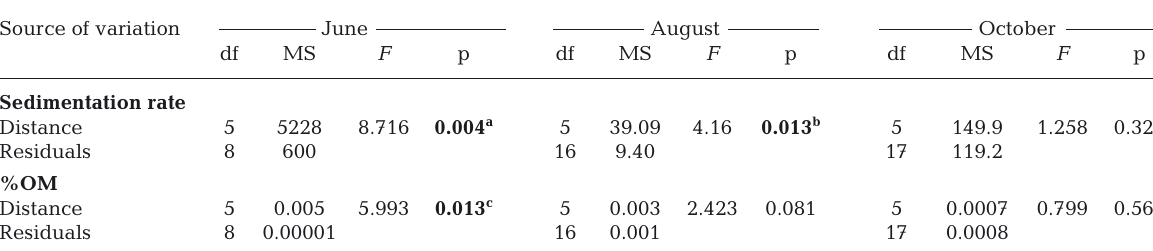
Table 1. Results of ANOVA evaluating the effect of distance on sedimentation rate and organic matter content (%OM) in sediment traps under the double density longline in June, August and October 2013. Bold values highlight significant effects at p < 0.05